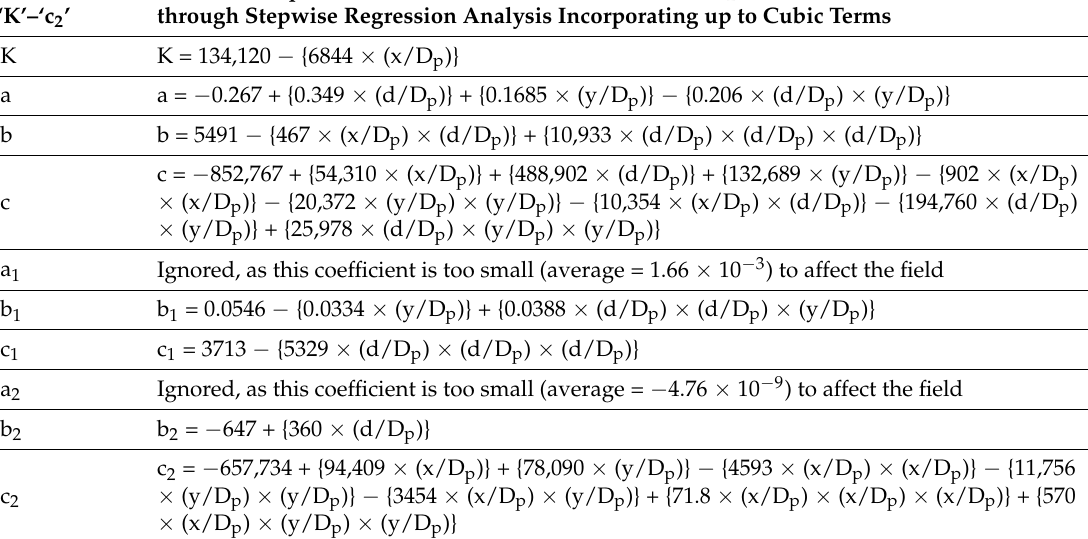
Table 6. Regression equations for predicting K, a, b, c, a 1 , b 1 , c 1 , a 2 , b 2 and c 2 for the Far Field. Coeff. of (A) Prediction Equations of the Unknown Coefficients (K~c 2 ) for the Far Field, ‘K’–‘c 2 ’